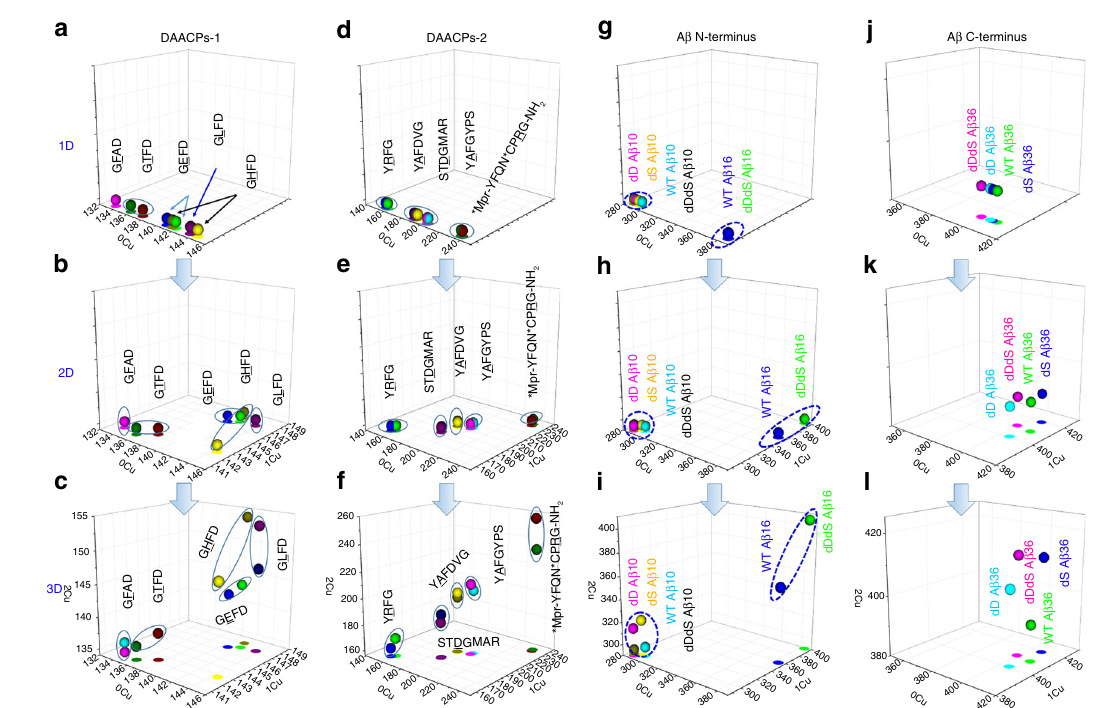
Fig. 2 Metal-enhanced multidimensional epimeric monomer discrimination. Group 1 ( a – c ): short neuropeptides 1 – 5 ; Group 2 ( d – f ): long neuropeptides 6 – 10 ; Group 3 ( g – i ): A β N-terminal fragments 11 – 12 and Group 4 ( j – l ): A β C-terminal fragments 13 . With the increase of separation dimensions (sequential binding with Cu 2 + ), signi fi cantly improved separation ef fi ciency is achieved for a wide range of neuropeptides and A β fragments (30 in total). All CCS data denote average values ( n = 3). Source data are provided as a Source Data fi le